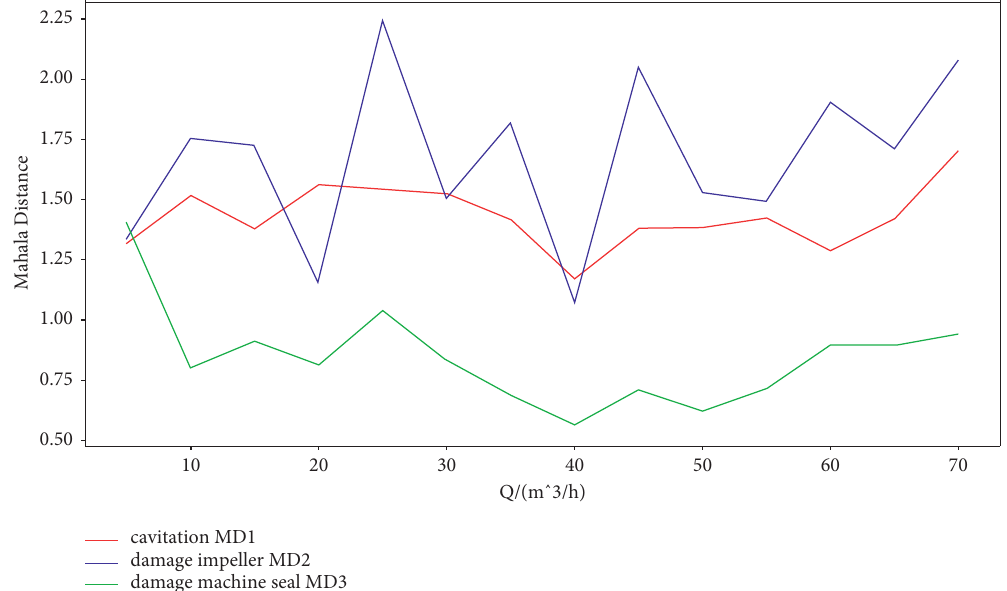
Figure 3: Mahalanobis distance diagram under different working conditions. Table 3: Partial Mahalanobis distance